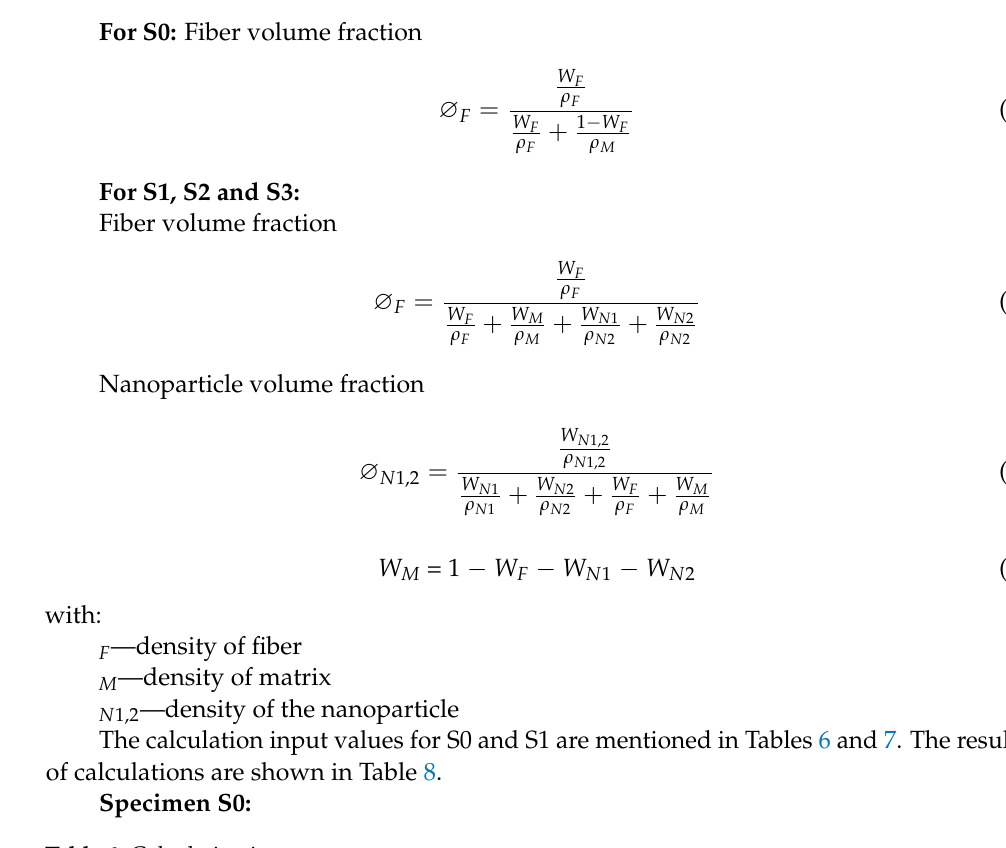
Table 6. Calculation inputs.